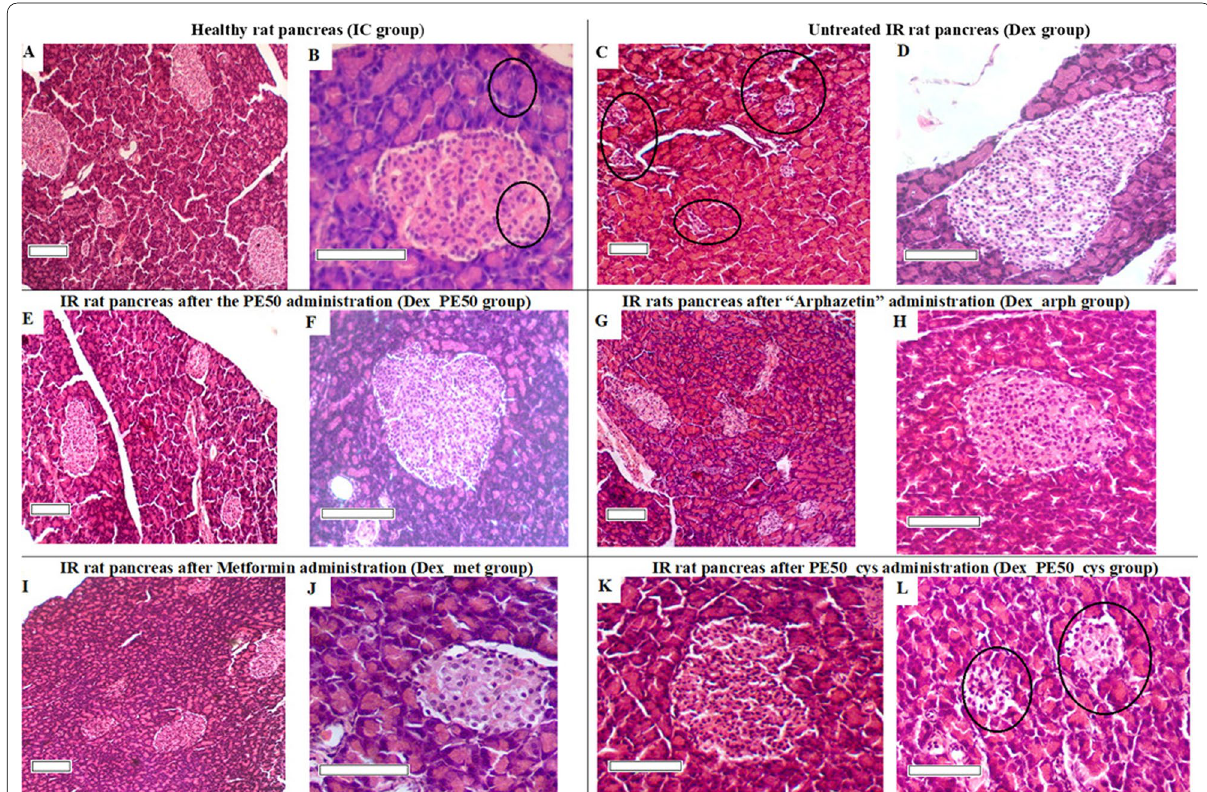
Fig. 3 Photomicrograph of rat pancreas, H&E. A Normal size distribution of pancreatic islets ( are not changed ( 250). C Increased number of small pancreatic islets ( × islands average size ( 100). F Normalization of beta cells in the islet ( × islands state reparation ( 200). I Visual restoration of the pancreatic islets number ( × vacuolation ( 250). K Unchanged pancreatic islet ( × bar: 100